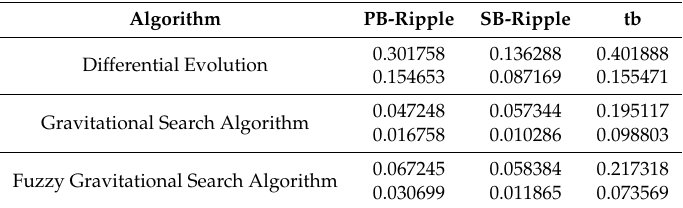
Table 5. Pass band ripple, stop band ripple and transition band of HP filters.